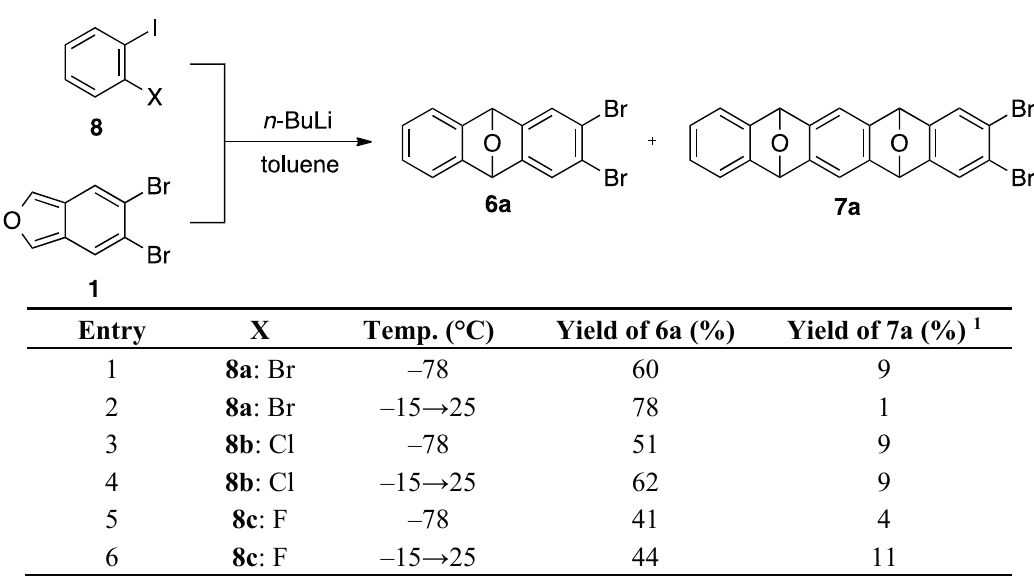
Table 1. Initial model